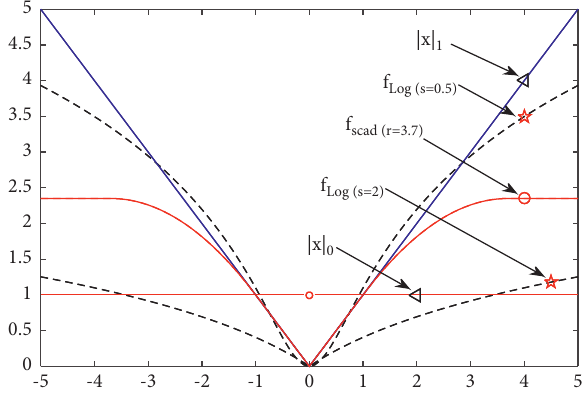
, | x | , SCAD function f 1 0